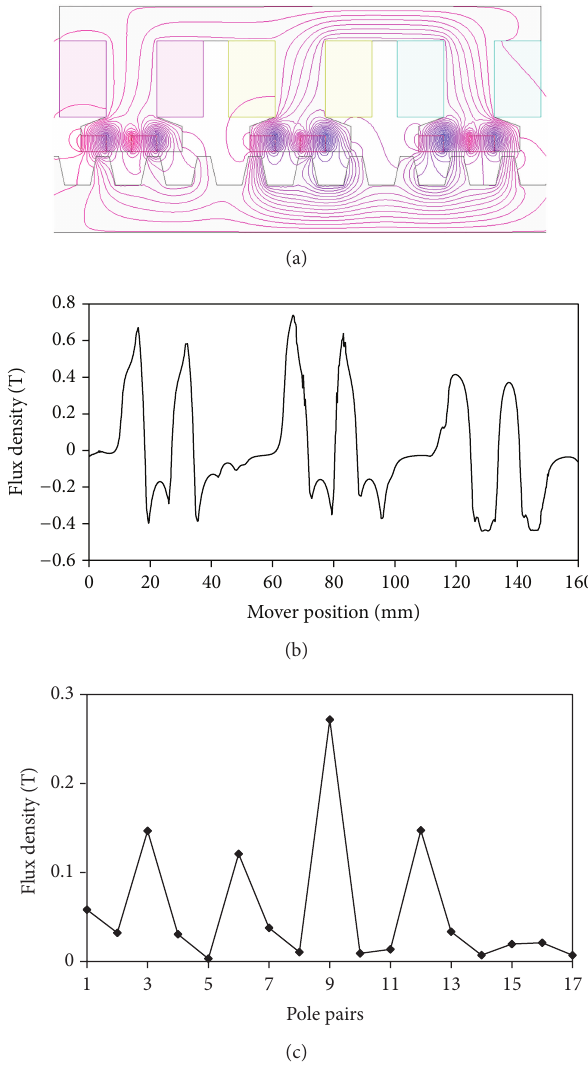
Figure 7: (a) No-load magnetic field distributions in the mover 1 at position A . (b) No-load air gap flux density. (c) Spectra.